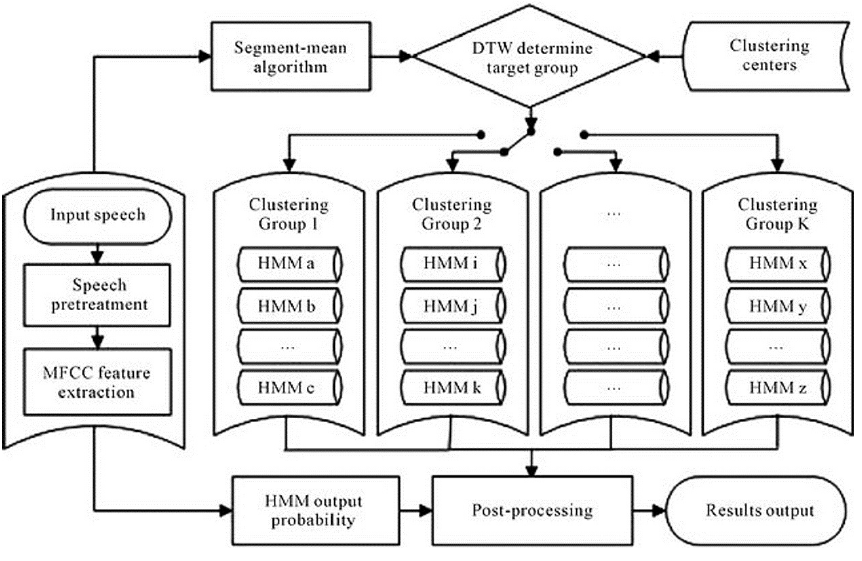
Fig. 2 Basic method steps of HMM